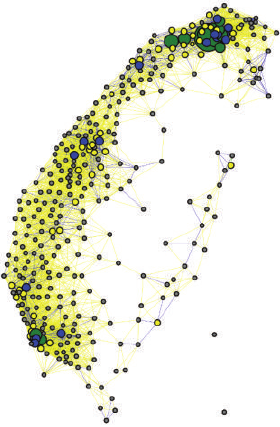
Figure 7: National commuting network in